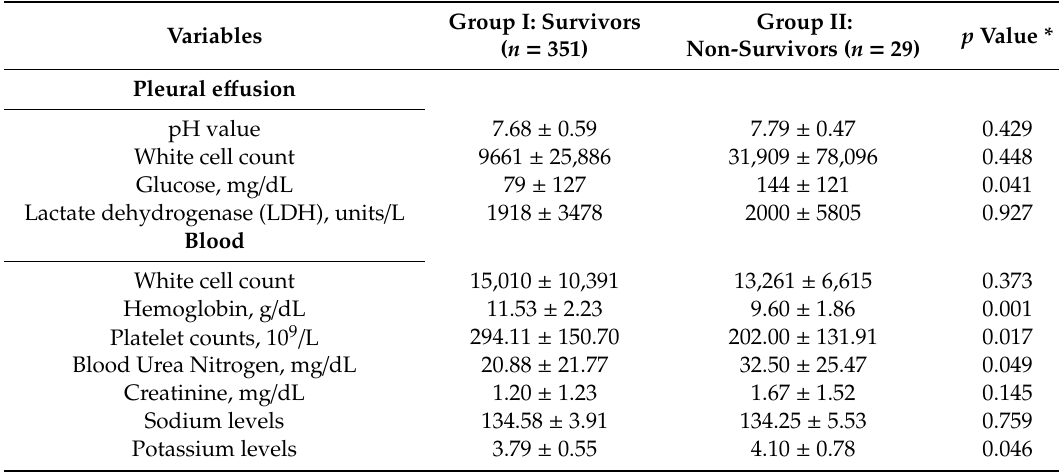
Table 3. Pleural fluid and laboratory findings